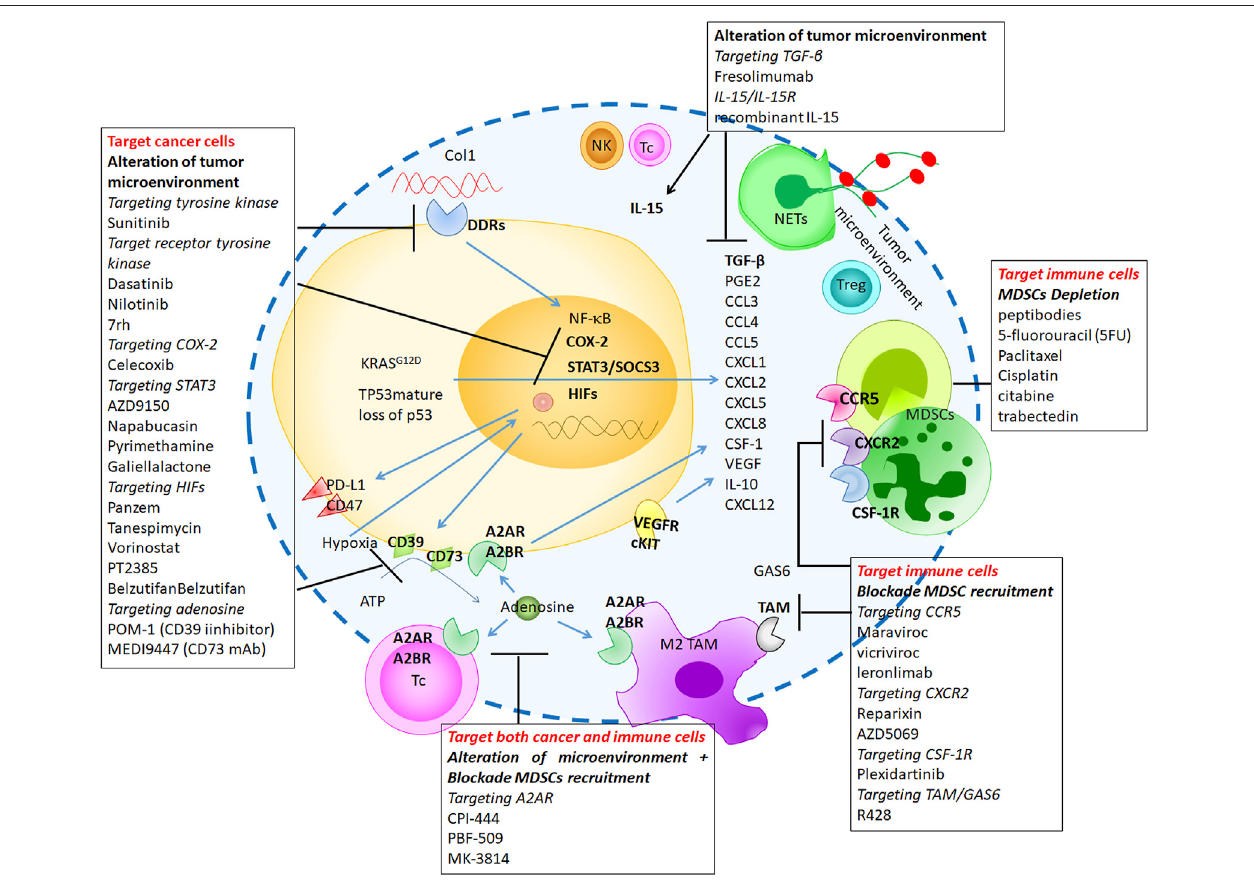
FIGURE 3 | The promising strategies targeting immunosuppressive-myeloid cells through cell depletion, blockade of known immunosuppressive signaling or alteration of TME.